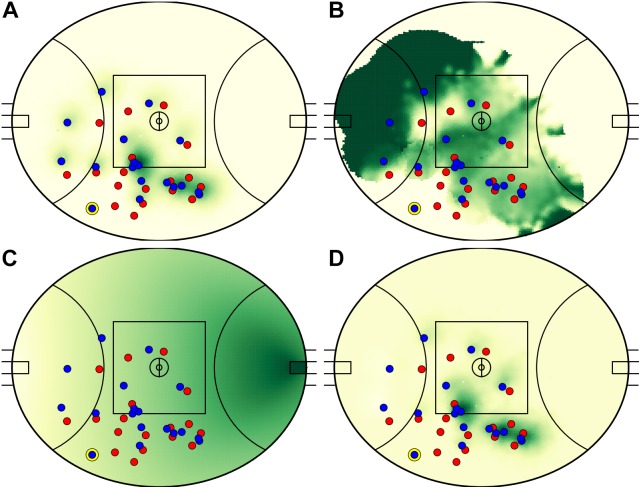
Team influence (A), dominance (B), field equity (C), and resultant expected outcomes (D) relative to the player in possession (circled in yellow, toward the lower boundary). High value space is represented as darker green regions. Team influence measures the spatial influence of the attacking team (whose players are in blue), while dominance measures their spatial ownership relative to the opposition (whose players are in red). All values are calculated relative to the player in possession. When complete, the model presented in this paper identifies two high value areas toward the center square, both viable passing options (see D).